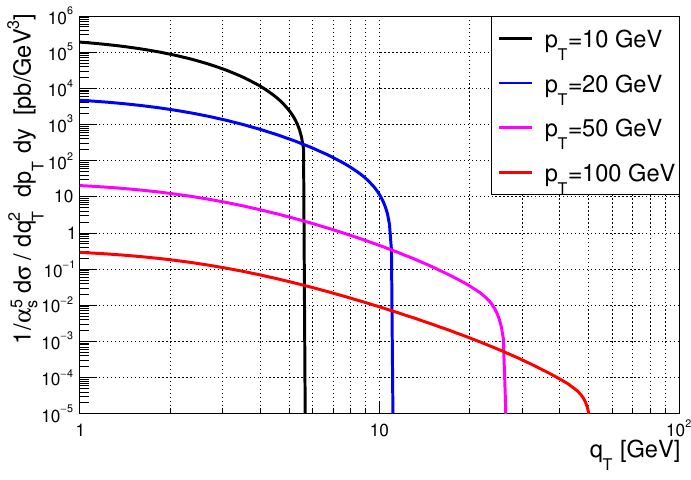
Figure 7 . Partonic cross section with the correlated Pomeron loop, eq. (3.4) unintegrated over the momentum transfer q T as a function of the momentum transfer for di(cid:11)erent values of the transverse momentum of the produced vector meson. Evolution variable in the BFKL equation is (cid:22) (cid:11) s y = 0 : 4.